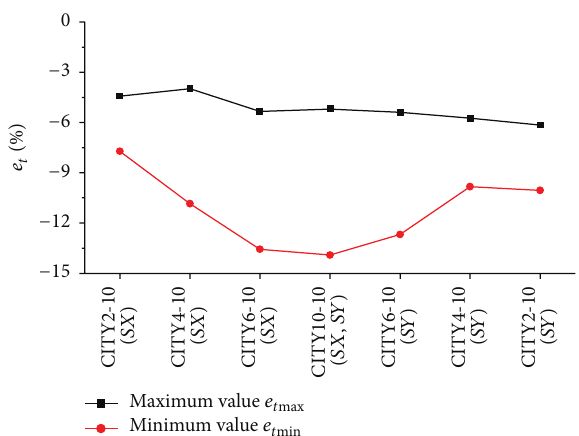
Figure 24: Interaction among structures in terms of influence coefficients 𝑒 𝑡 max and 𝑒 𝑡 min for structural groups with different arrangements (MCH000, 𝑆𝑋 or 𝑆𝑌 ).